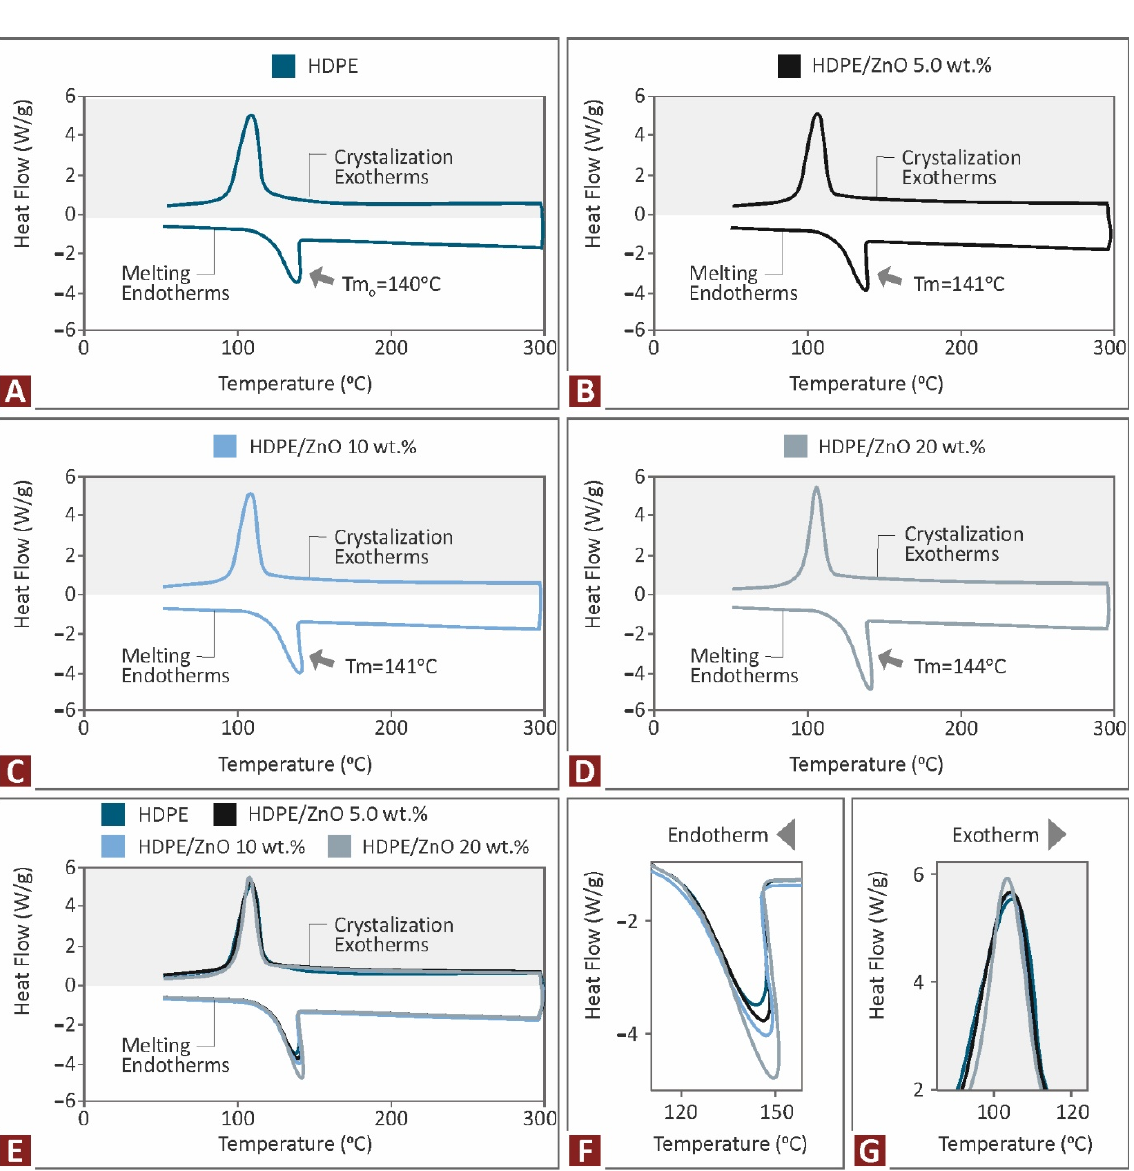
Figure 6. DSC results for unfilled HDPE thermoplastic and HDPE with ZnO composites at ( A ) 0 wt.%, ( B ) 5 wt.%, ( C ) 10 wt.%, ( D ) 20 wt.%; ( E ) DSC comparative graphs for unfilled HDPE thermoplastic and HDPE with ZnO composites; and ( F , G ) zoom areas of the melting endotherm peaks ( F ) and crystallization exotherm peaks ( G ).